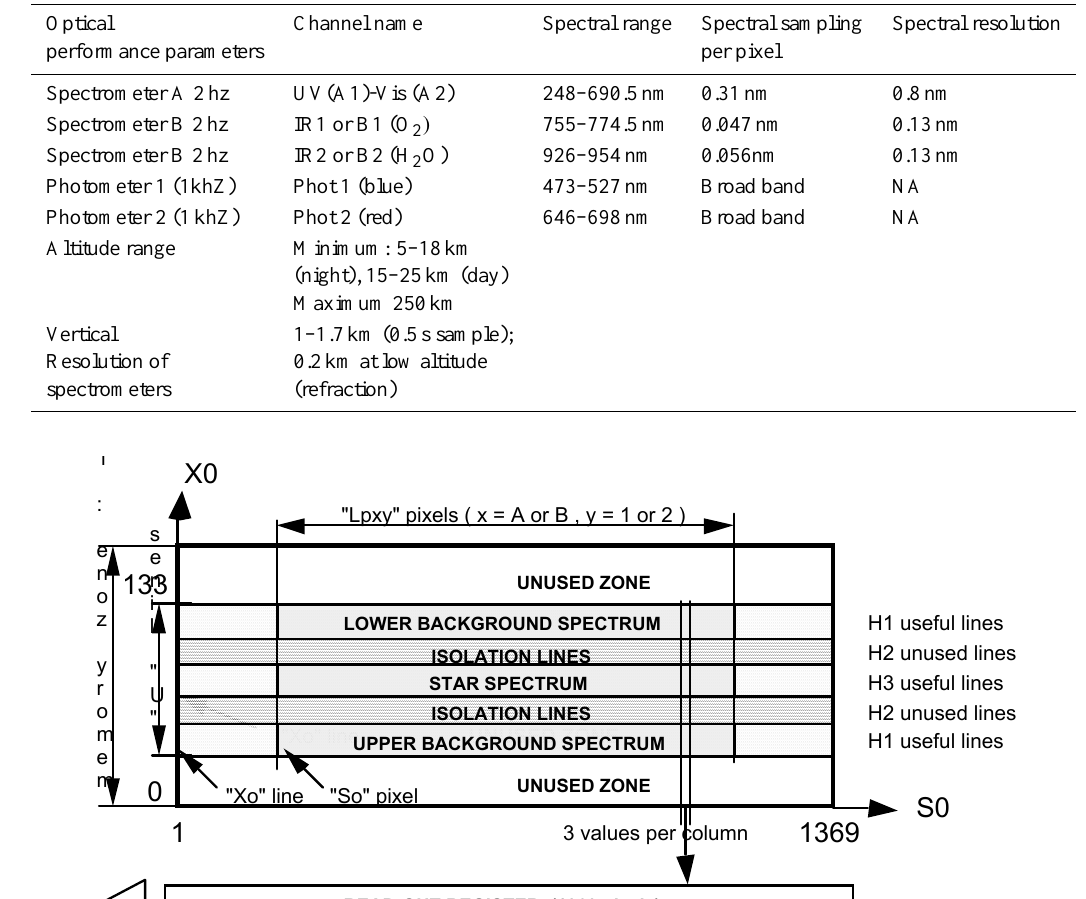
Table 1. GOMOS instrument parameters.